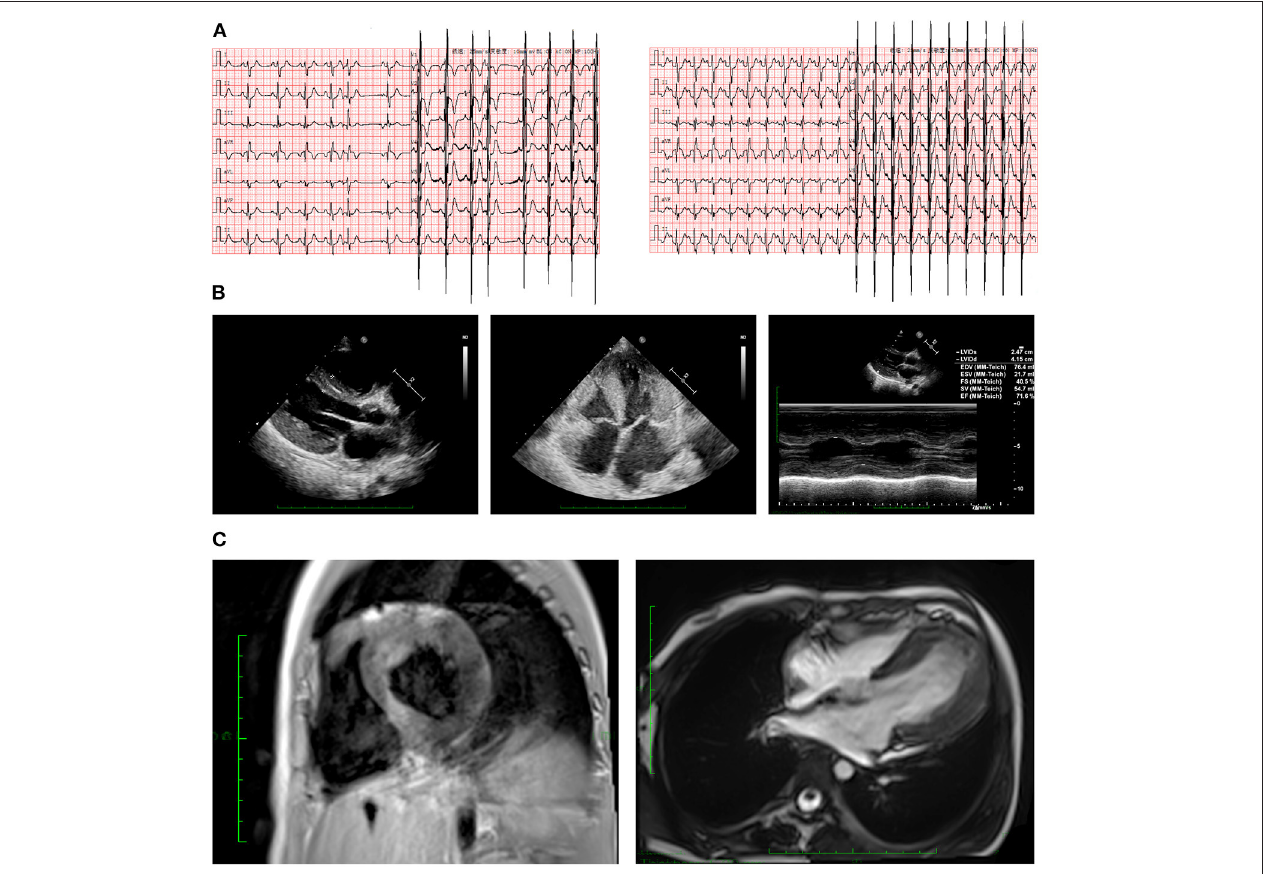
FIGURE 1 | Clinical manifestations in ECG and imaging. (A) ECG revealed CRBBB, abnormal double atrium, ventricular hypertrophy, first-degree atrioventricular block, and ST segment changes (lead I, aVL, and V3–V6 depression > 0.05mV). (B) Echocardiography indicated severe LVH. (C) Cardiac magnetic resonance imaging depicted hypertrophic left ventricular wall in both short axis and long axis views. CRBBB, complete right bundle branch block; ECG, electrocardiogram; LVH, left ventricular